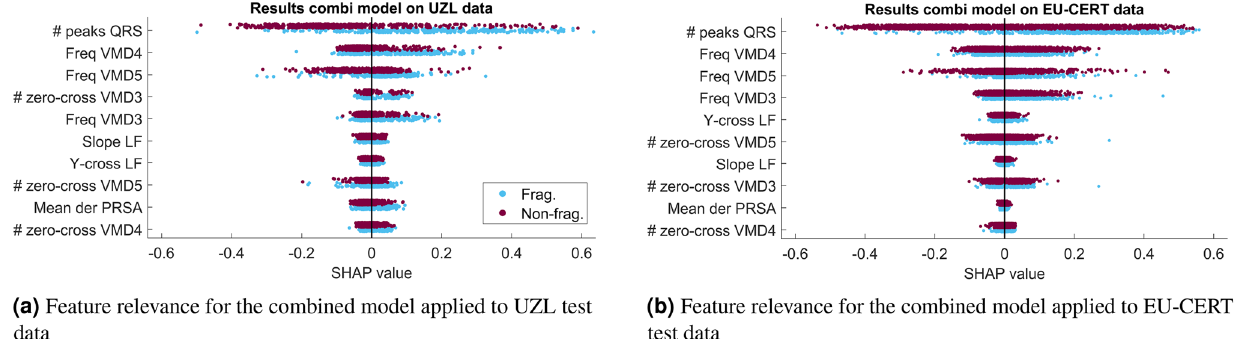
Figure 9. SHAP analysis of UZL and EU-CERT test signals for the combined